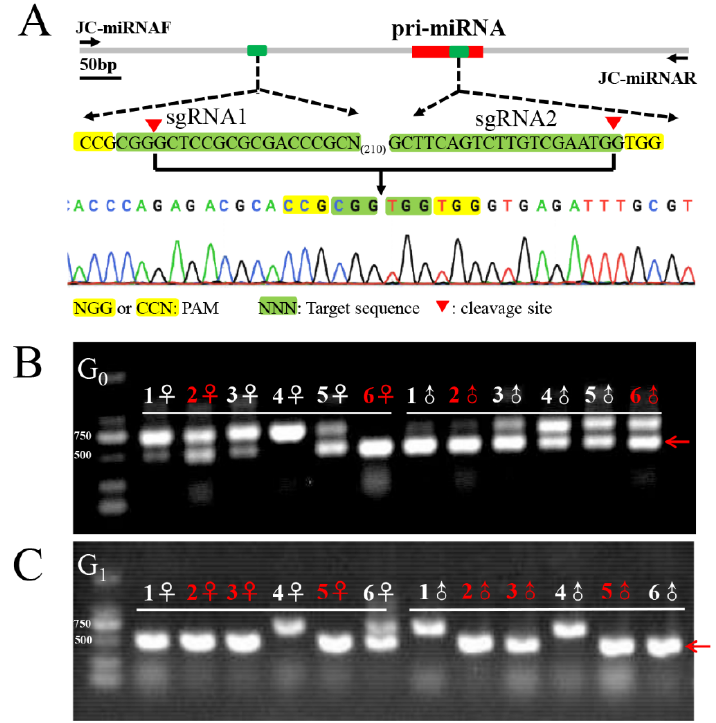
Figure 1. CRISPR/Cas9-induced genomic mutagenesis. Schematic representation of the single guide RNA (sgRNA) targeting sites ( A ). The green rectangle indicates the location of the sgRNAs target sequence; The red rectangle indicates the position of pri-miRNA sequence. Amplification by PCR to determine the genomic mutagenesis of individual moths in G 0 ( B ). DNA fragments were amplified by PCR from the genomic DNA of the G 0 moths after oviposition. The red arrow indicates deletion events in the genomic region between the two target sites across this region. The red number on the top indicates the single-pair number of G 0 moths that were selected to produce G 1 offspring. ( C ) Amplification by PCR to determine the genotype of individual moths in G 1 . The red number indicates female or male individuals, which are homozygous, that were selected to produce G 2 off- spring.